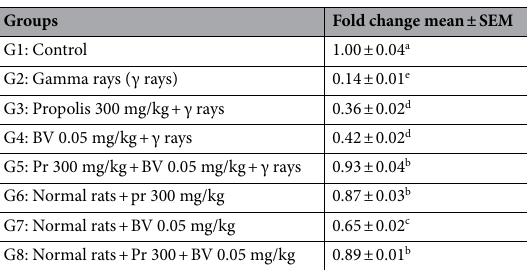
Table 2. Changes in relative expression of miRNA125b gene in serum of radiated rats following treatment by propolis and/or bee venom. Means within carrying different superscript letters are significantly different (P ≤ 0.05). Pr propolis, BV bee